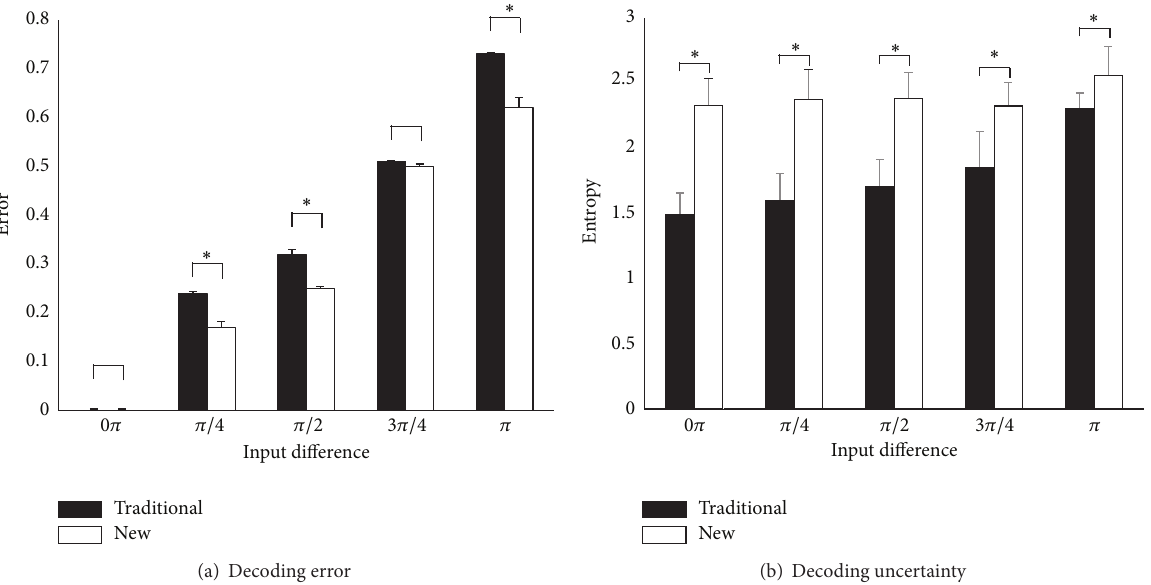
Figure 5: A comparison of decoding error and uncertainty under various degrees of stimulus direction difference between the proposed (new) and the traditional maximum entropy decoders. (a) Both decoders demonstrate a similar trend of higher error rates for greater input difference. Except for the 0.75𝜋 condition, the proposed method yields significantly lower error rates ( 𝑡 -test, 𝑃 < 0.00001 ). (b) A sensible increase of uncertainty is shown for both methods as the input difference grows. The proposed method contains greater uncertainty ( 𝑡 -test, 𝑃 < 0.01 ) for all